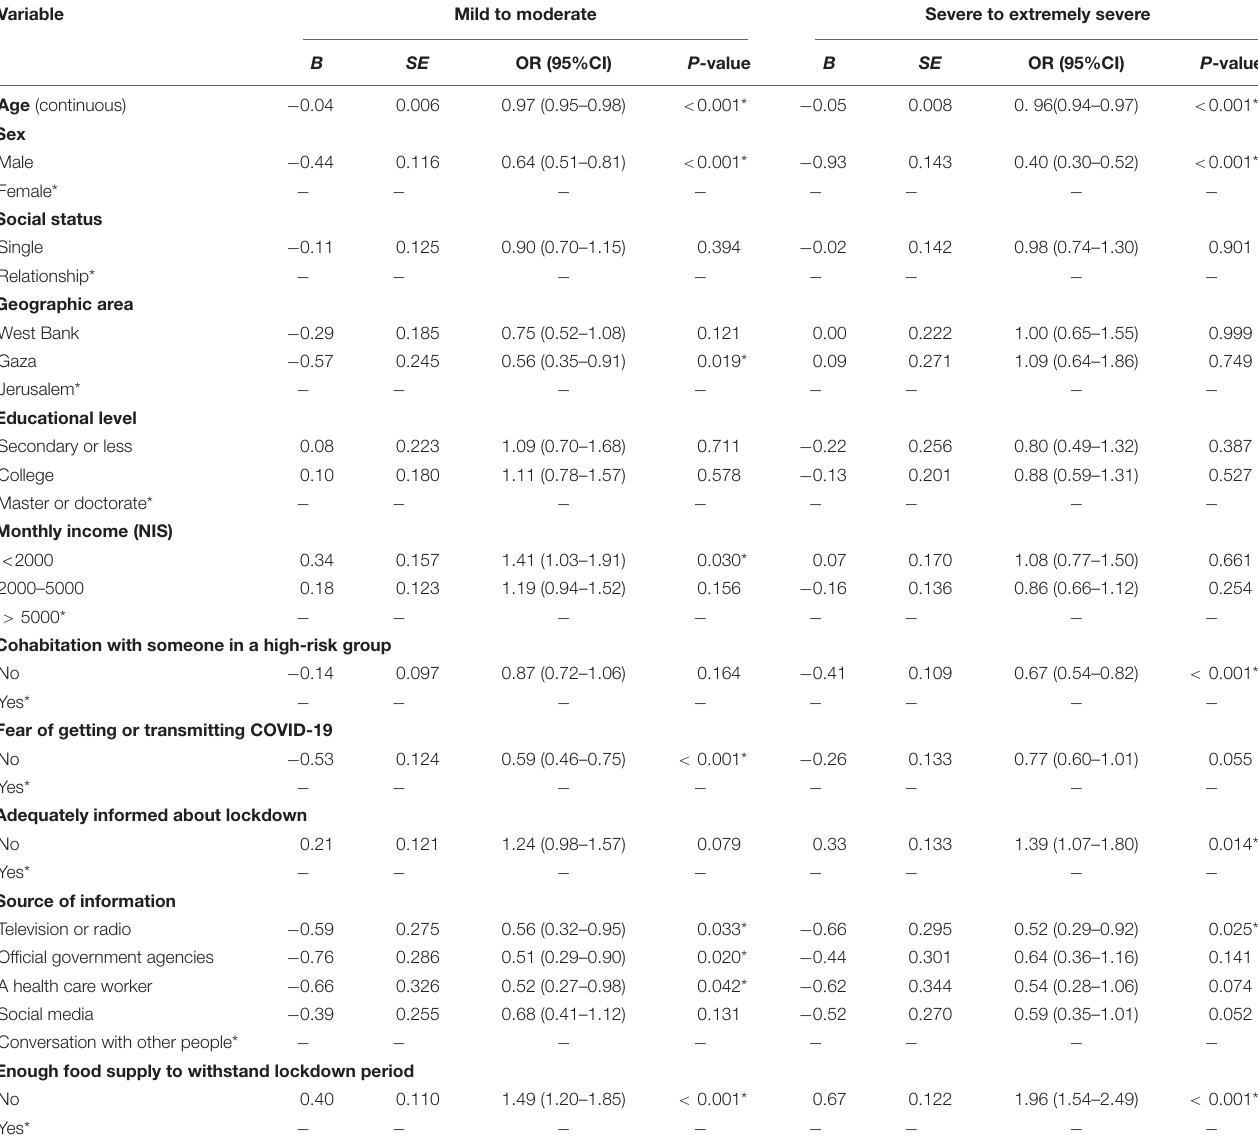
TABLE 4 | Multinomial regression model for the variables associated with stress severity # ( N = 2819). Variable Mild to